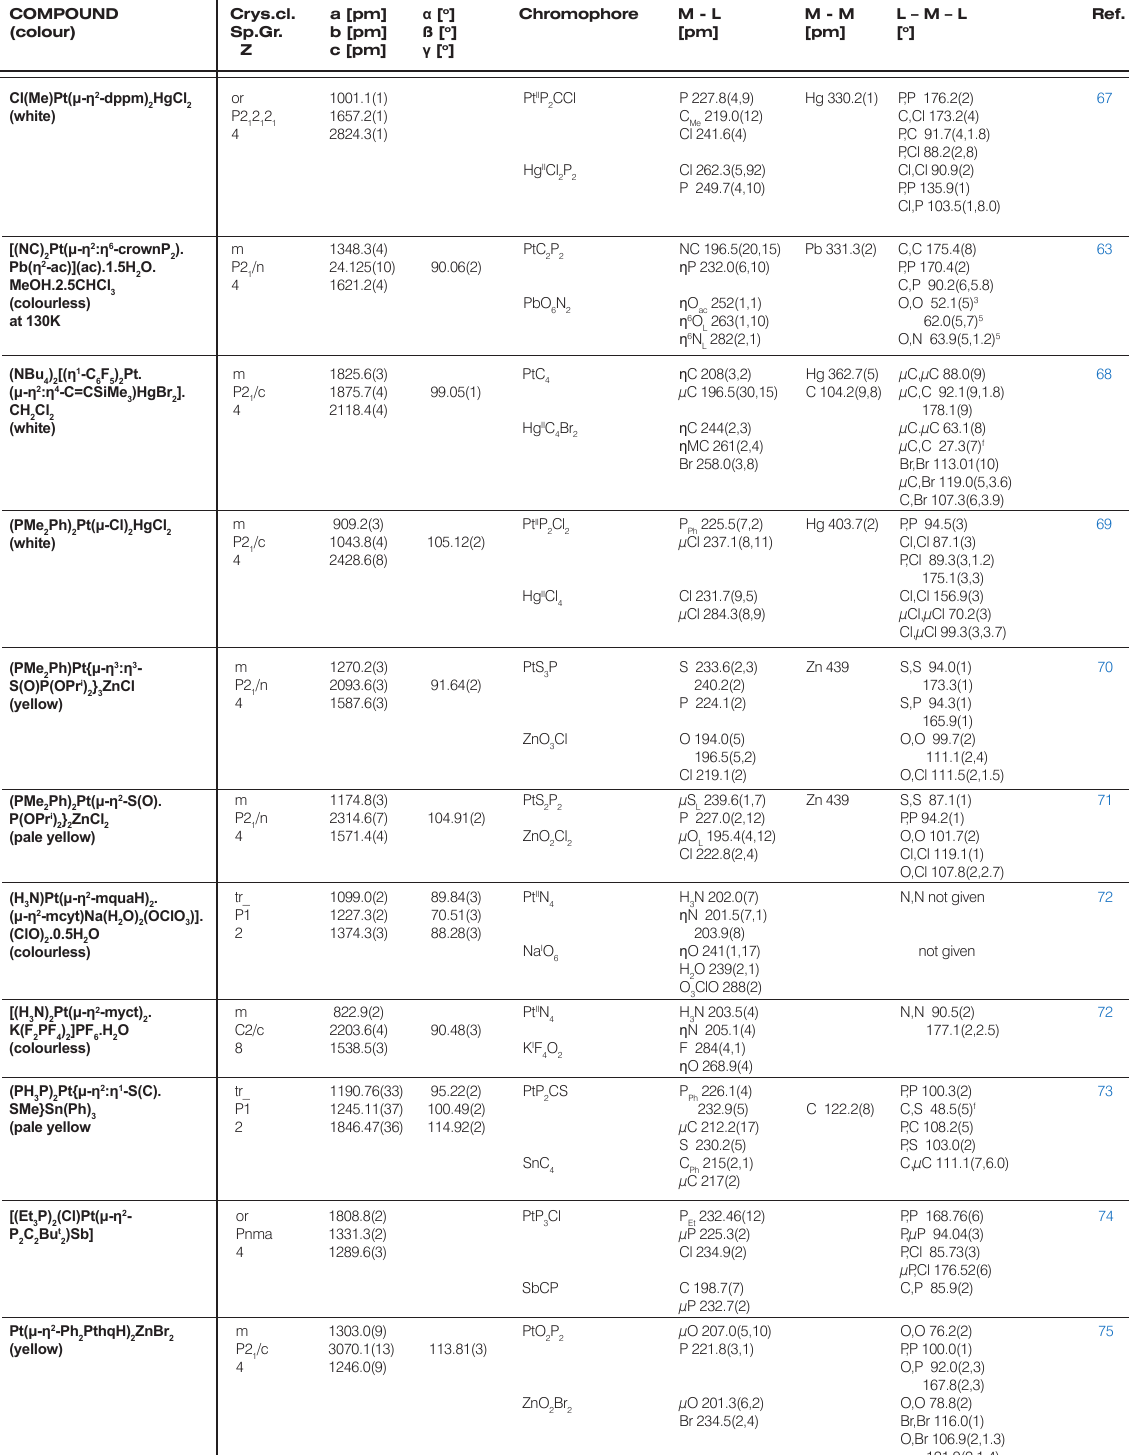
Footnotes: a Where more than one chemically equivalent distance or angle is present, the mean value is tabulated. The first number in parenthesis is the e.s.d., and the second is the maximum deviation from the mean. b The chemical identity of the coordinated atom or ligand is specified in these columns. c Five membered metallocyclic ring. d Four